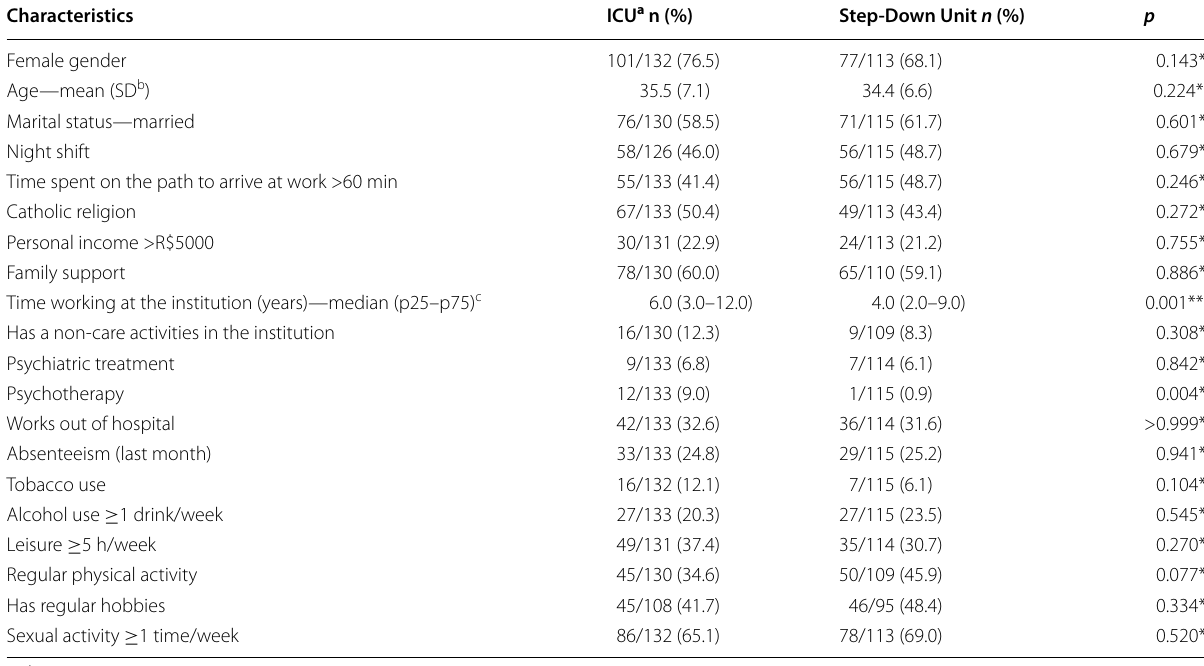
Table 1 Characteristics of healthcare providers according to their